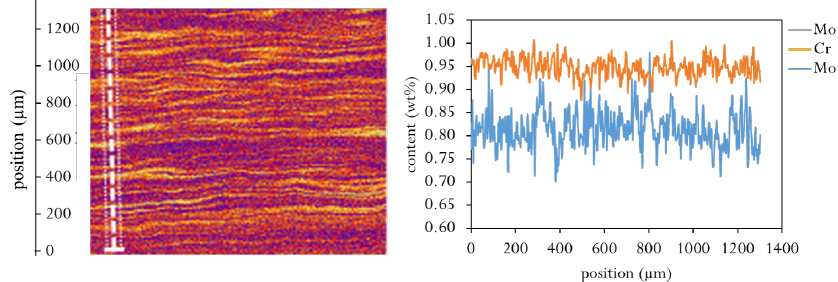
Figure 3. Segregation profile of Mo and Cr across a line scan (white line) detected using electron probe micro analysis (EPMA).